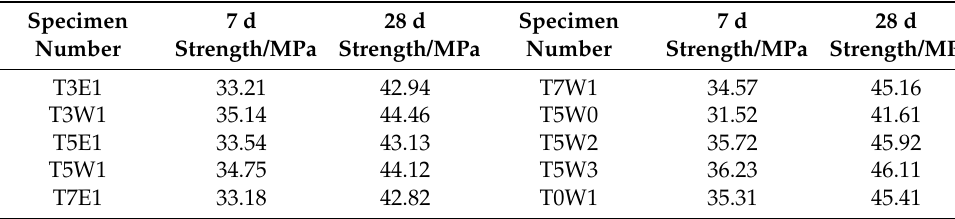
Table 4. Compressive strength of concrete cube test block under the same condition